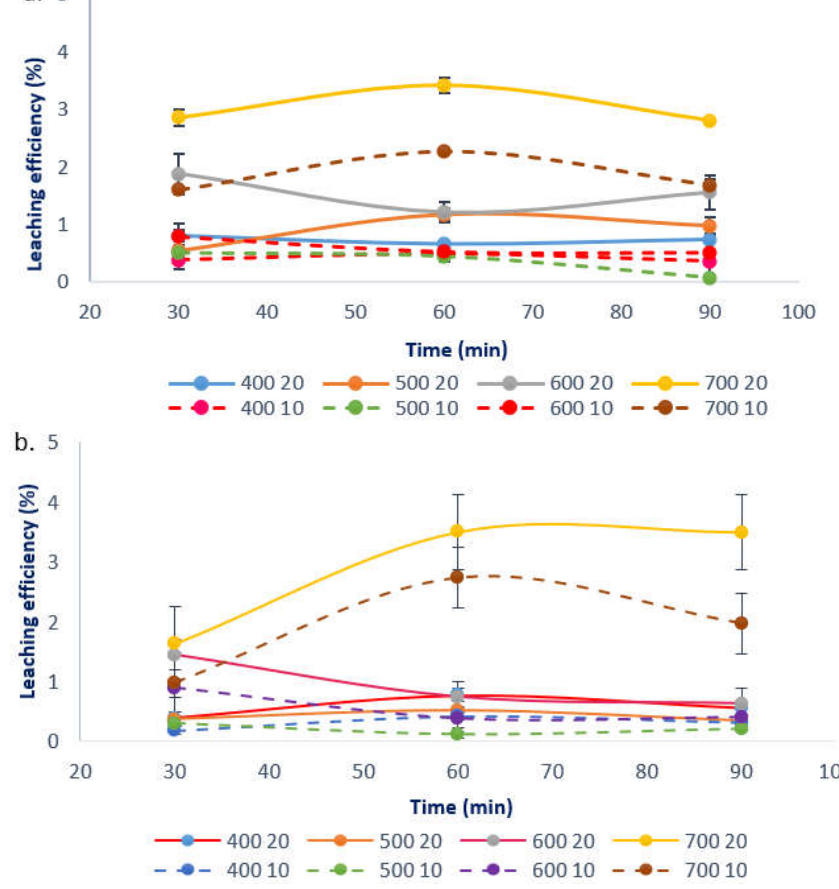
Figure 8. The effect of L/S ratio on Al leaching efficiency: ( a ) pyrolysis and ( b ) incineration (Leaching condition: L/S ratio = 20:1 and 10:1 mL g −1 , 80 °C, 300 rpm, and 3 h). condition: L/S ratio = 20:1 and 10:1 mL g − 1 , 80 ◦ C, 300 rpm, and 3